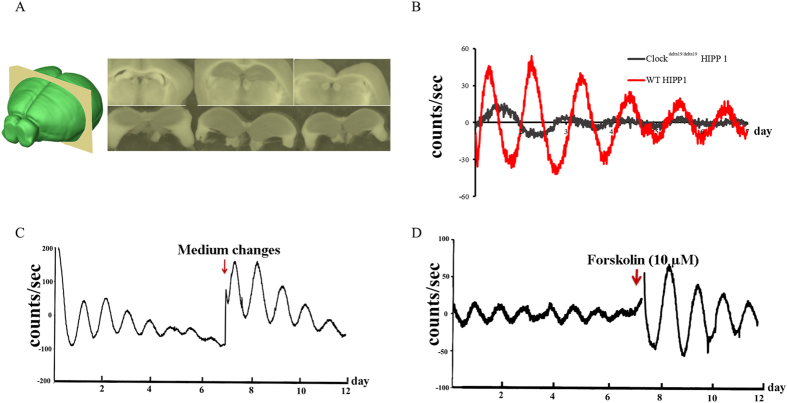
A self-sustained circadian oscillator exists in the hippocampus.(A) Dissected hippocampus slices in ice-cold 1 × HBSS buffer (PH = 7.2–7.4). (B) Deficiency of Clock leads to the attenuation of circadian rhythms in the hippocampus. We recorded the real-time luciferase activity of Clockdelta19/delta19; mPer2luc/luc and WT control hippocampus slices and found an attenuation of circadian rhythms in Clock mutants. (C) The oscillation of the hippocampus slices was damped after one week in ex vivo culture conditions. However, medium changes at days 7–8 induced synchronization of hippocampal oscillation (D) Forskolin (10 μM) treatment induced synchronization of hippocampal oscillation.